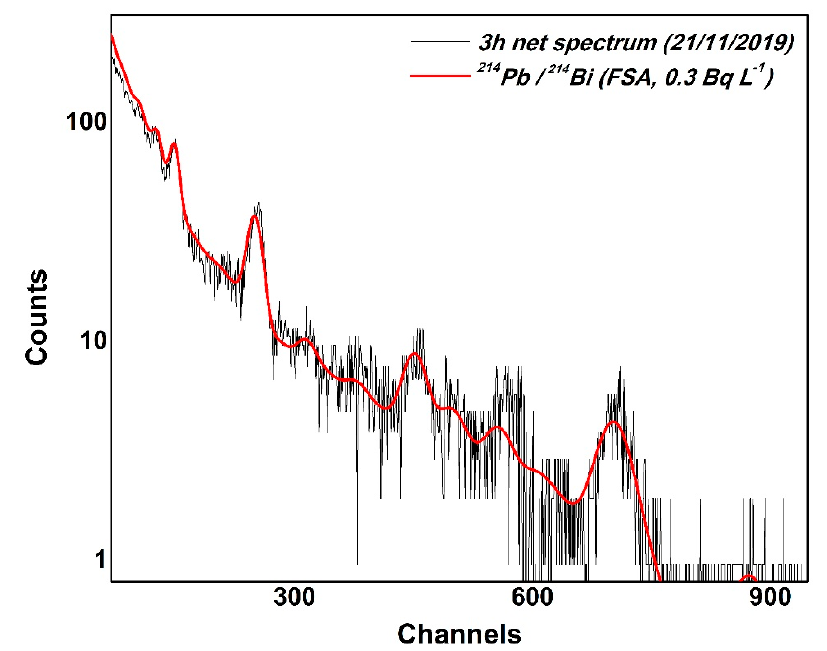
Figure 5. The experimental and reproduced spectra (after subtraction of the background spectrum) of the radon progenies ( 214 Pb, 214 Bi). The activity concentration for both progenies is 0.3 Bq L − 1 , and the acquisition time is 3 h.